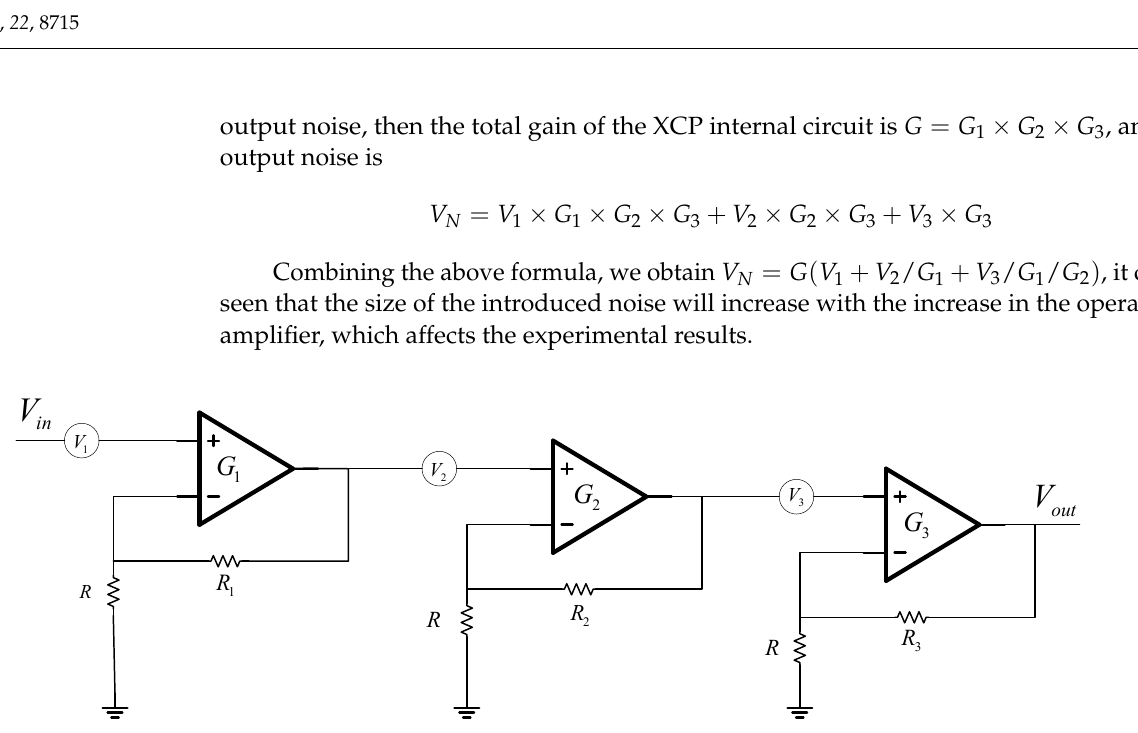
Figure 3. Simplified circuit of XCP op amp noise model: consists of a basic operational amplifier circuit whose magnification is mainly determined by two external resistors.